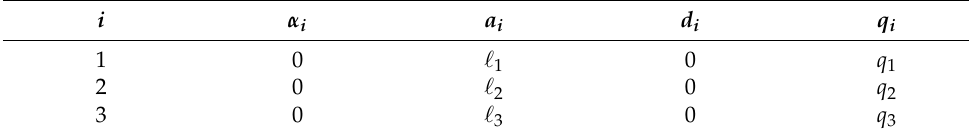
Figure 1. LLRR configuration. Table 1. D-H Parameters for our 3-DOF